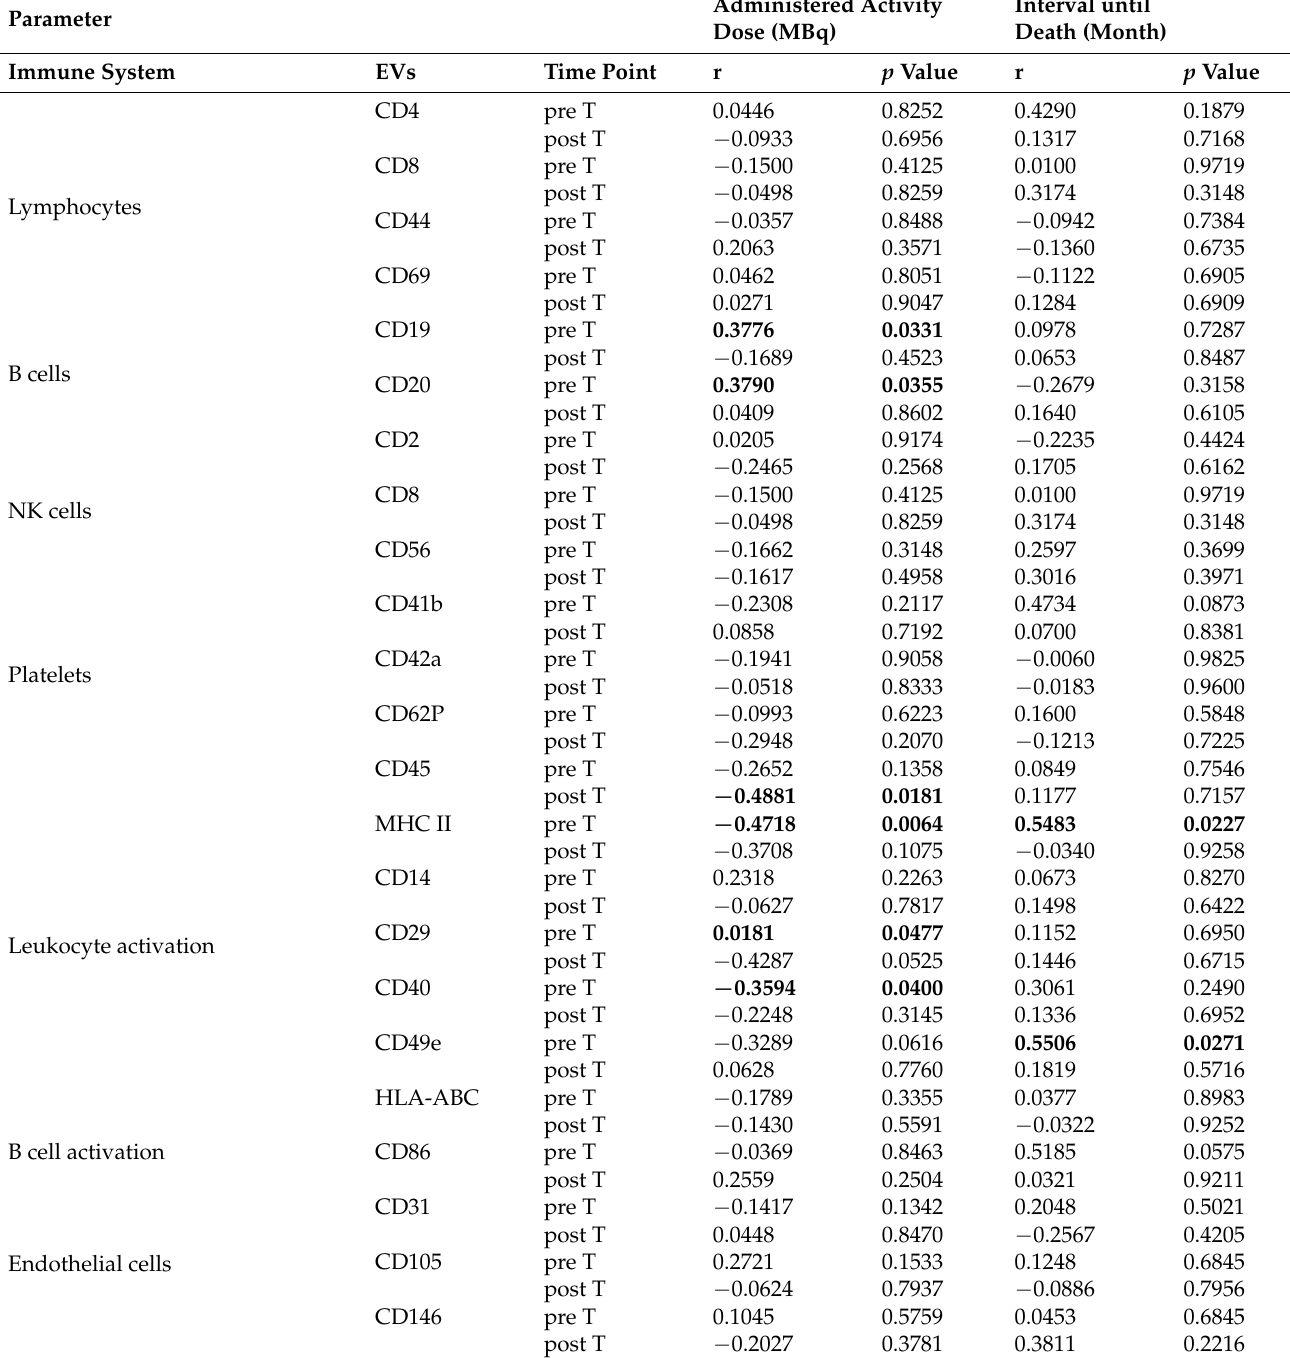
Table 3. The correlation analyses between the parameters of the immune system assessed on extra- cellular vesicles (EVs) either with the administered activity dose (MBq) or with the interval until death (month) were performed by determining the Spearman correlation significance and Spearman r. Expression levels of cluster of differentiation (CD) proteins on the surface of EVs isolated from cholangiocellular carcinoma patients (CCA) one day before (pre T) and two days (post T) selective internal radiotherapy radioembolization were used. A p value below 0.05 was considered statistically significant. Abbreviations: HLA, human leukocyte antigen; MHC, major histocompatibility